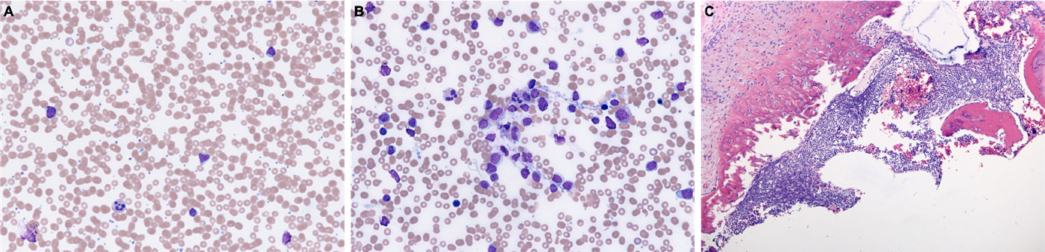
Figure 3. Morphology of B-ALL in peripheral blood and bone marrow. ( A ) Peripheral blood smear and ( B ) bone marrow aspirate smear highlighting numerous circulating small to medium-sized blasts with high nuclear to cytoplasmic ratio, irregular nuclei, open chromatin, small nucleoli, and scant cytoplasm (original magnification × 400, Wright–Giemsa stain). ( C ) Bone marrow core biopsy demonstrating diffuse involvement by B-ALL (original magnification × 100, hematoxylin and eosin stain). All images were taken using an Olympus BX50 microscope and a SPOT Insight 4 camera and SPOT 5.0 advanced